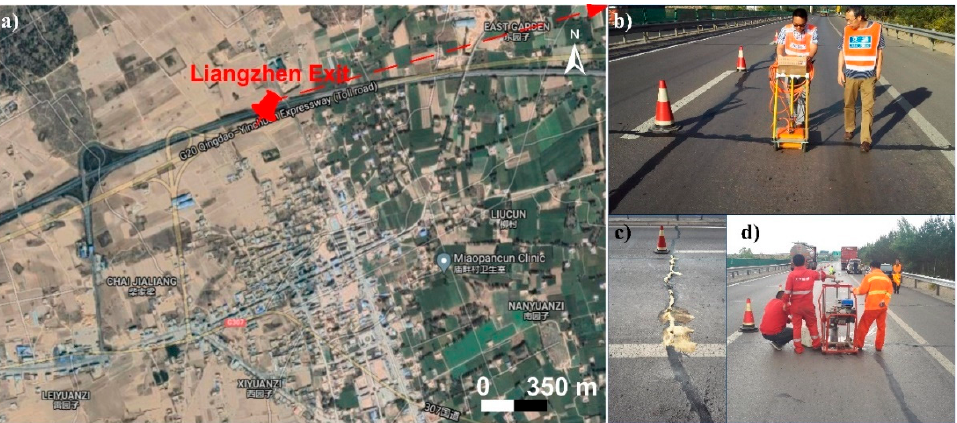
Figure 8. ( a ) The selected highway pavement for surveying near the Liangzhen Exit of G20 Qingdao- Yinchuan Expressway (Shaanxi Province, China). ( b ) Radar data acquisition. ( c ) Full-depth treatment on reflective crack. ( d ) Core-drilling equipment.